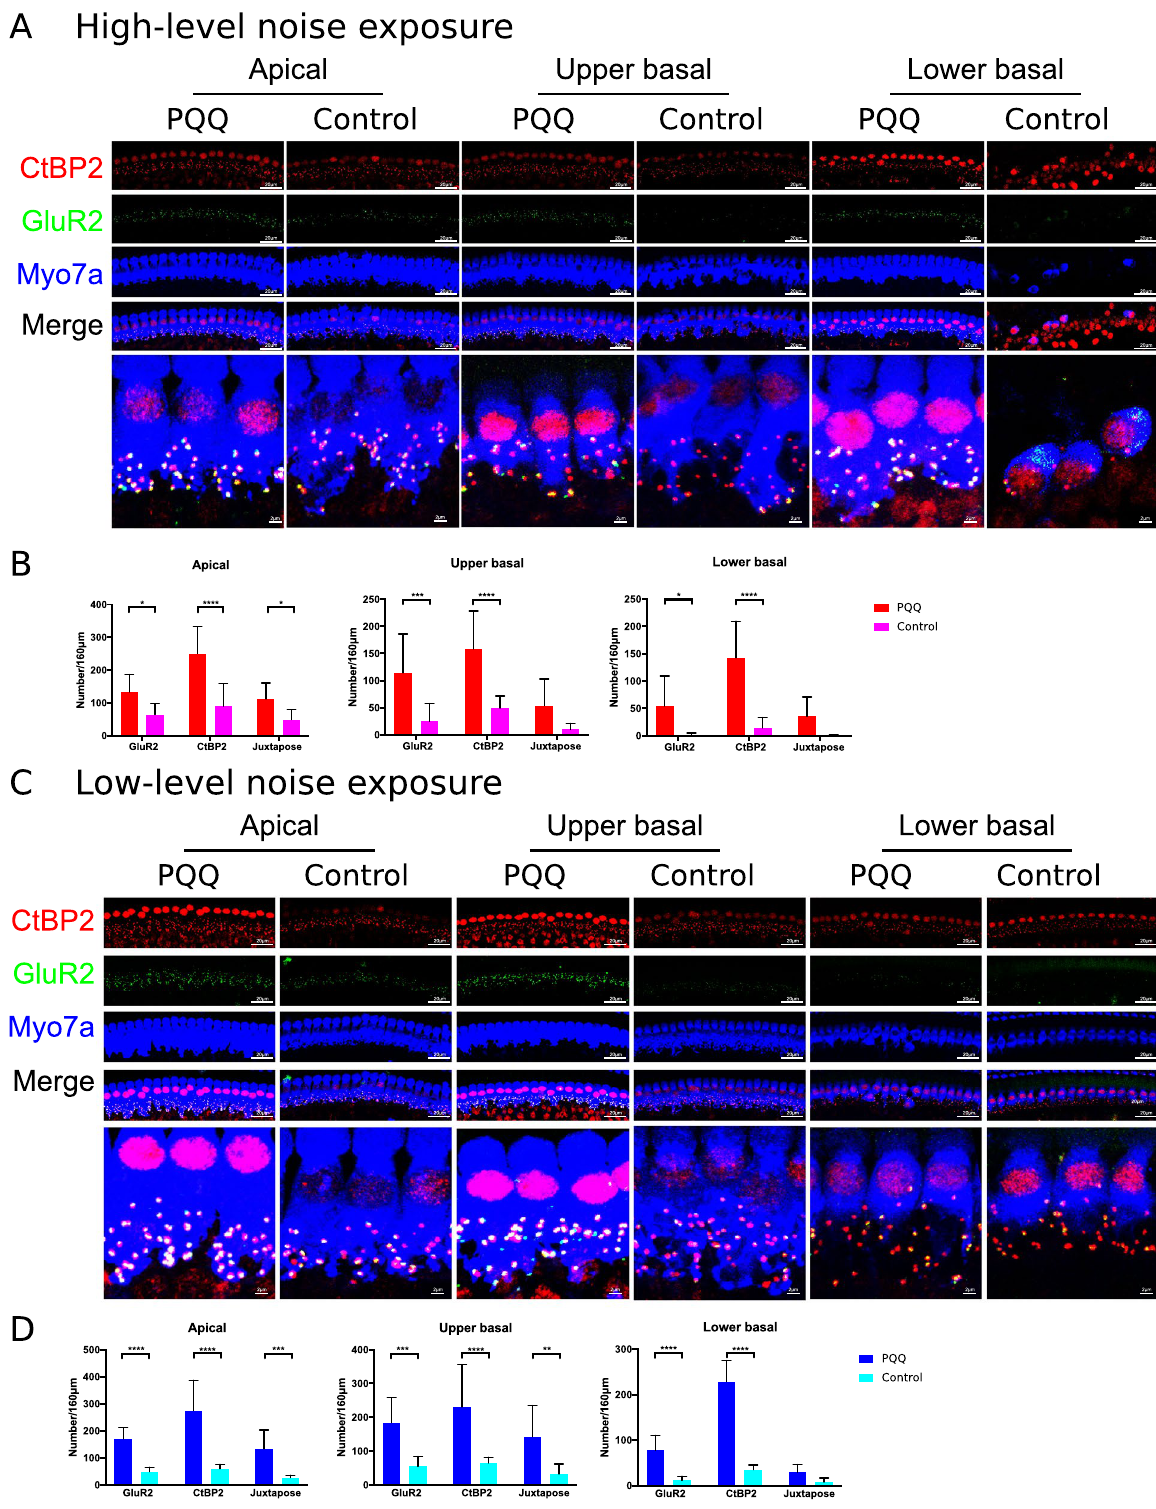
Figure 3. The evaluation of ribbon synapses in the noise-induced hearing loss model (A) Confocal images of the ribbon synapses of IHCs of the cochlea in NIHL after exposure to high-level noise. The pre-synaptic marker (CtBP2, red), the post-synaptic marker (GluR2, green) and the hair cell marker (Myo7A, blue) are immunolabeled. Bar, 20 µm, 2 µm in the magnified box. (B) The number of ribbon synapses of the IHCs per 160 µm of sensory epithelium. Juxtapose is the number of juxtaposed pre-synaptic marker (CtBP2) and post-synaptic marker (GluR2). (C,D) The confocal images of ribbon synapses and the numbers of the ribbon synapses respectively after exposure to low-level noise. * p < 0.05, ** p < 0.01, *** p < 0.001, **** p < 0.0001. (n = 5 per